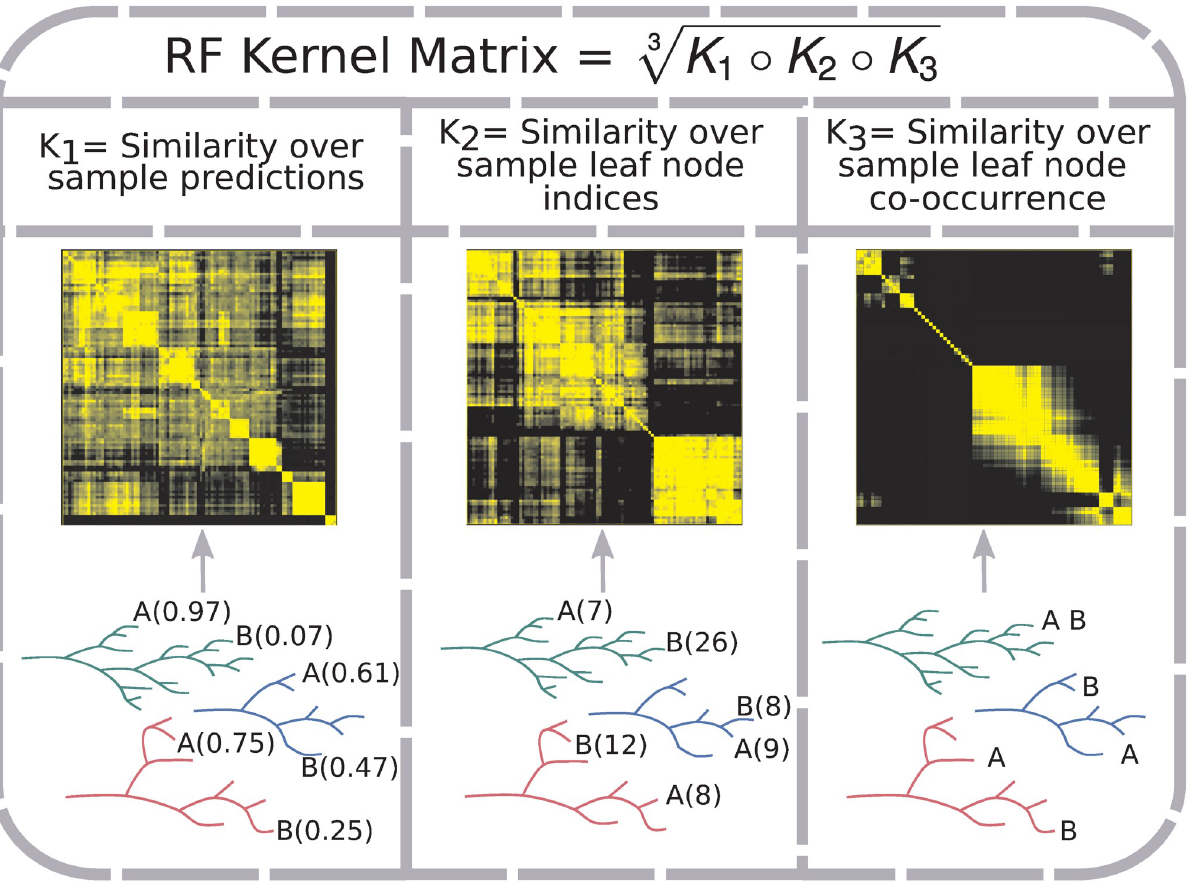
Fig 5. RF kernel matrix construction. The RF Kernel matrix is a geometric mean of the Hadamard product of three component similarity matrices. Each component captures a different aspect of a RF model. K 1 captures the similarity over RF tree predictions for sample labels (in the case of classification, probability of belonging to a class); two samples (A and B) show different predicted probabilities of belonging to the positive class (probability estimate in parentheses). K 2 represents the similarity over RF tree leaf indices to which samples are assigned; predicted leaf indices shown in parentheses for the two samples. K 3 reflects the proportion of times samples are assigned to the same RF tree leaf; e.g. the two samples end up together in one out of three example